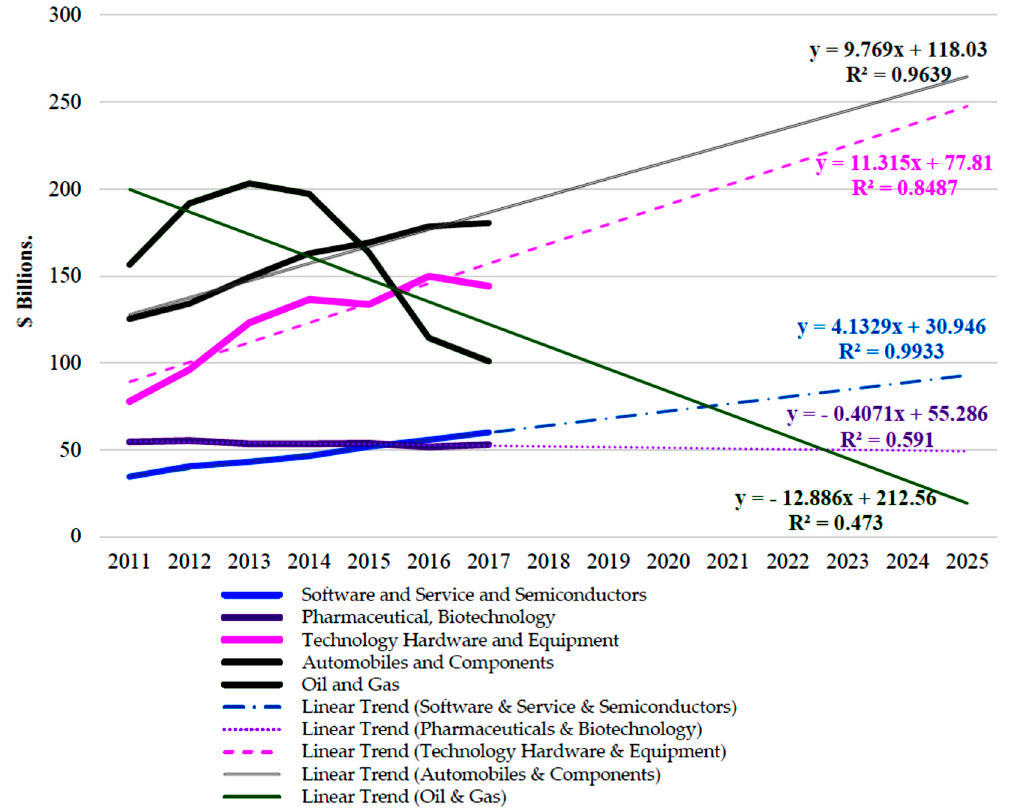
Figure 4. Forecast (Linear Trend) of revenue (income) of the Oil Companies in comparison with companies of other industries until 2025, in billions of dollars. Source: calc. by author by data [56].